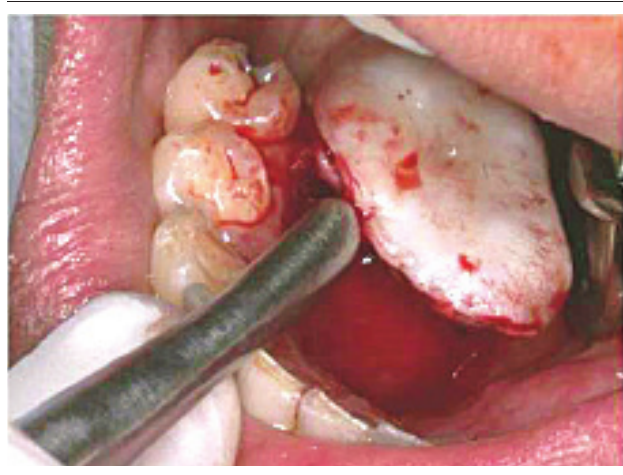
figurE 4 − Intraoral image showing the lesion